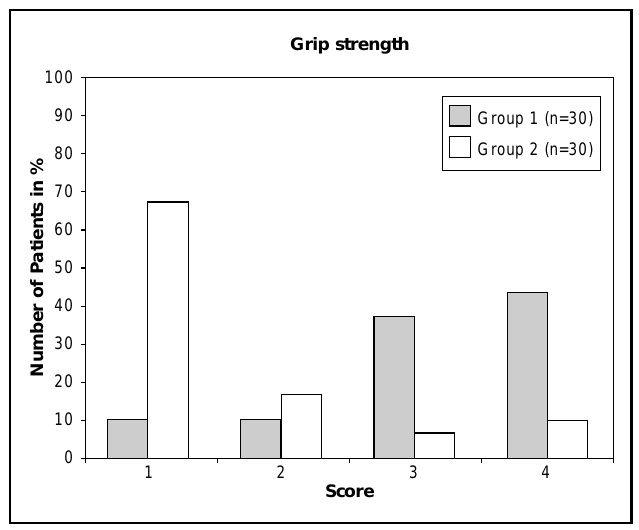
Figure 2: Distribution differences in provocation pain at the end of six weeks of treatment in the therapy groups.